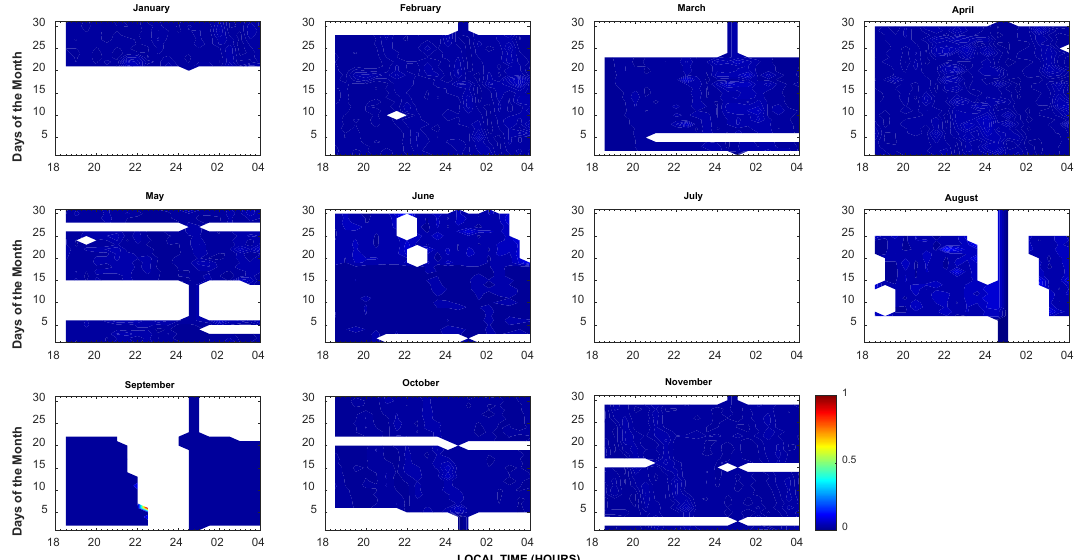
Figure 4. Monthly ROTI variation over the Bowen CASES GPS during 2021.